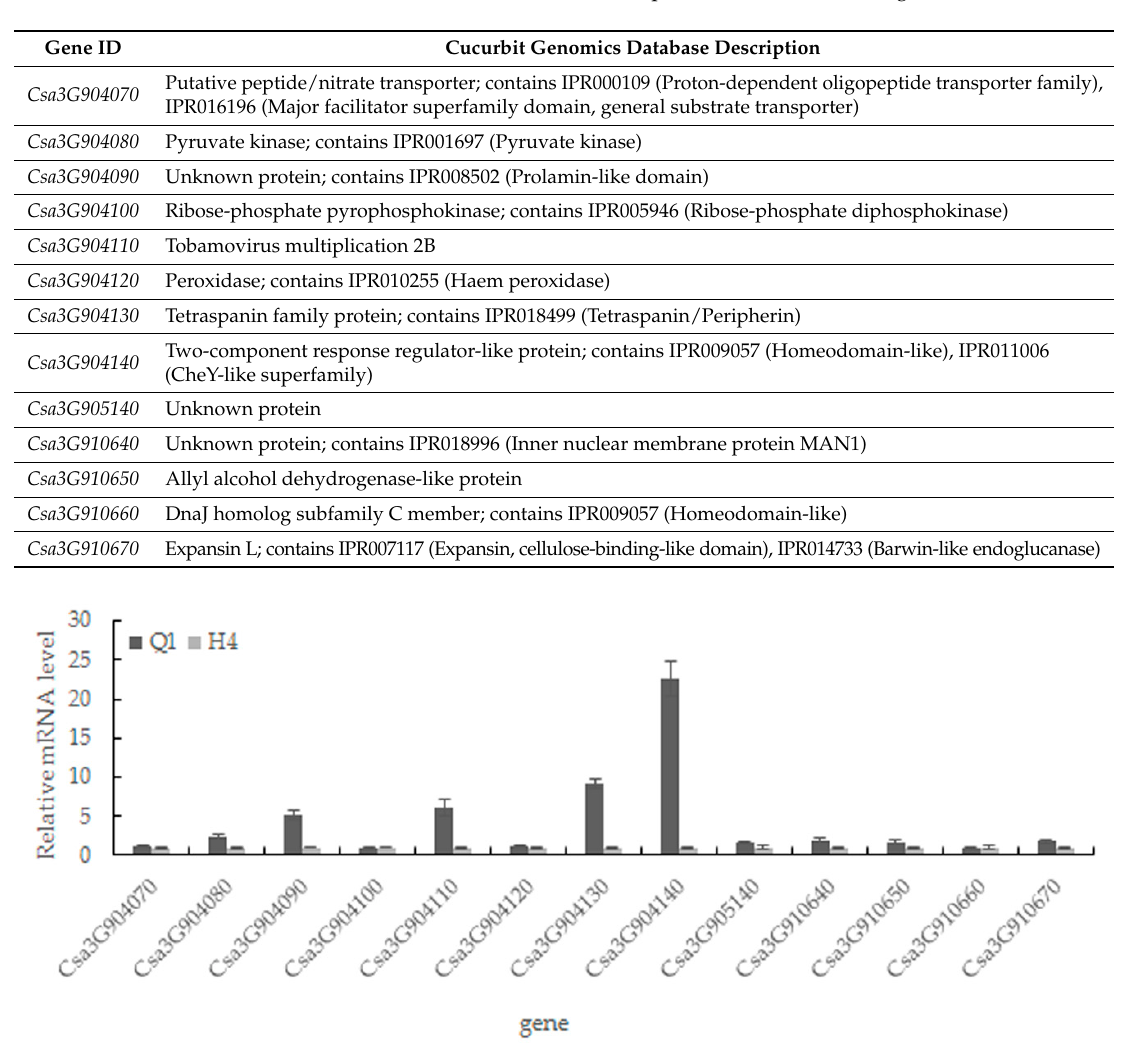
Table 2. The Cucurbit Genomics Database description of all 13 candidate genes.